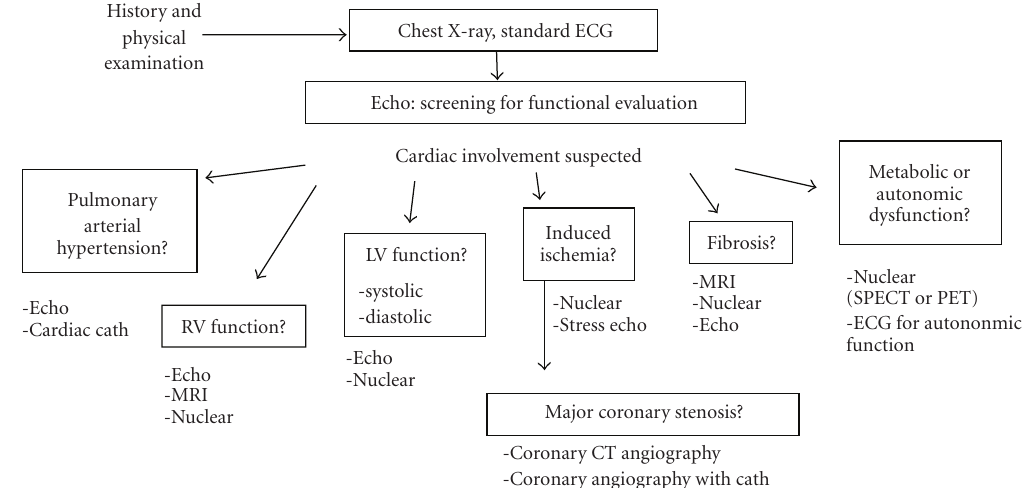
Figure 3: Possible roles of cardiac imaging modalities for diagnostic work-ups and followup in SSc. Abbreviations: ECG, electrocardio- graphy; Cath., catheterization; MRI, magnetic resonance imaging; CT, computed tomography; SPECT, single-photon emission computed tomography; PET, positron emission